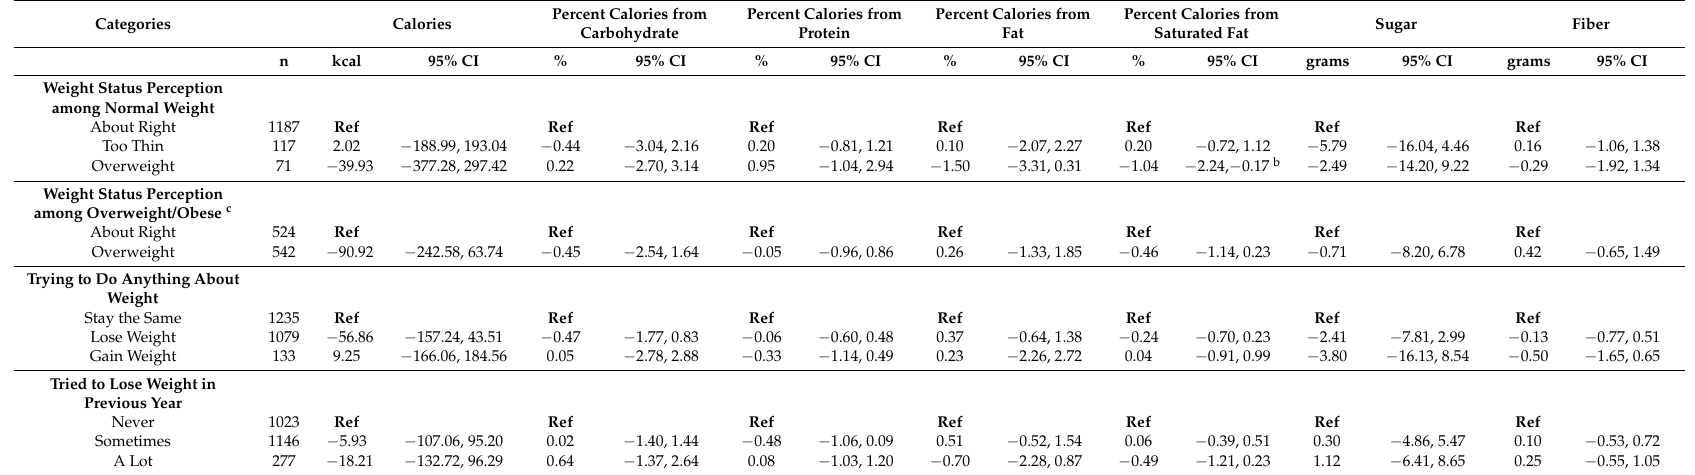
Table 4. Multivariable linear regression models estimating associations of weight status perception and weight control intentions with nutrient intakes a among